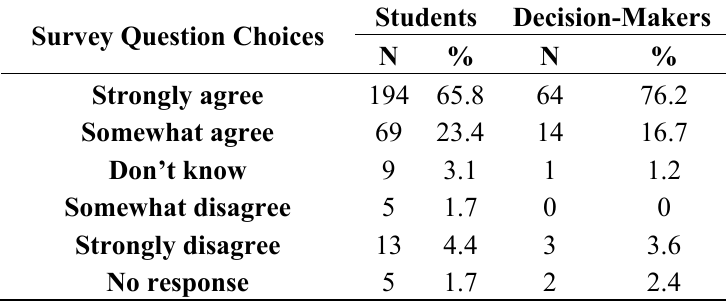
Table 3. Response to “human activity is responsible for climate change”.